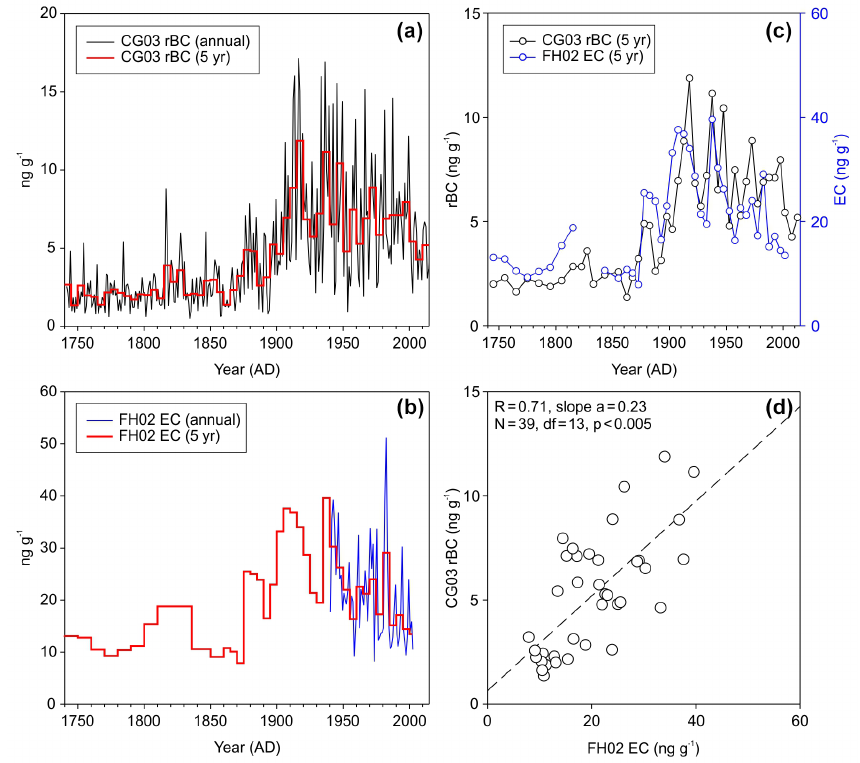
Figure 3. (a) Colle Gnifetti CG03 rBC concentrations and (b) Fiescherhorn FH02 elemental carbon (EC) concentrations (Jenk et al., 2006; Cao et al., 2013; Gabbi et al., 2015); (c) comparison of CG03 and FH02 ice cores resampled to the FH02 sampling resolution of 5–10 years with (d) linear fit and Pearson’s correlation coefficient R = 0 . 71, P < 0 . 005 (adjusted for a reduced sample size owing to autocorrelation of the data sets) indicated. Table 2. Median concentrations for selected chemical and elemental tracers from Colle Gnifetti during pre-industrial (PI), during time periods dominated by the fossil-fuel sources coal (COAL) and petroleum products (PETROLEUM).